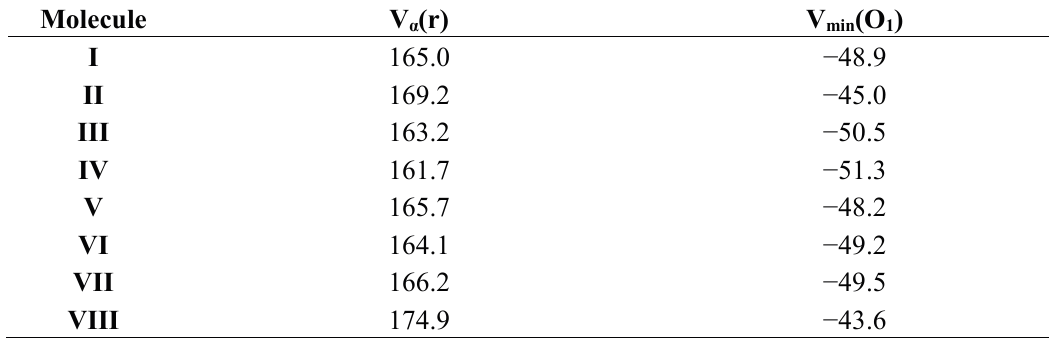
and V (r) (kcal/mol). min α